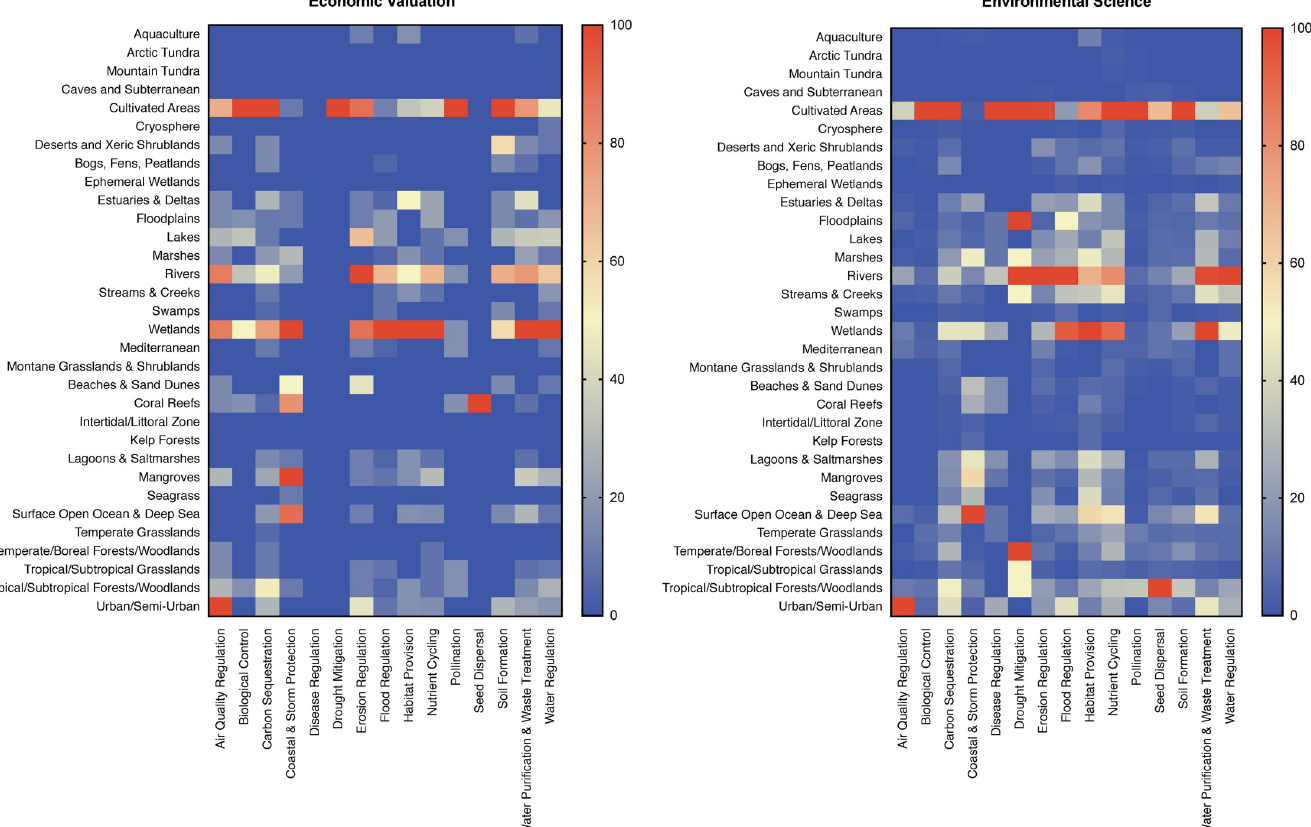
Fig 3. Research effort in environmental science and economic valuation. Heat map of economic valuation and environmental science research effort on each of N = 15 regulating and supporting ecosystem service and N = 32 ecosystem type combinations as estimated by retrieved article hits. Raw article hits were normalized based on the smallest (0%) and largest (100%) values in each data set to allow for direct and relative comparison between research domains with respect to relative article hits. Red cells indicate higher, blue cells indicate lower research effort for that combination of ecosystem service and ecosystem type relative to the average effort.